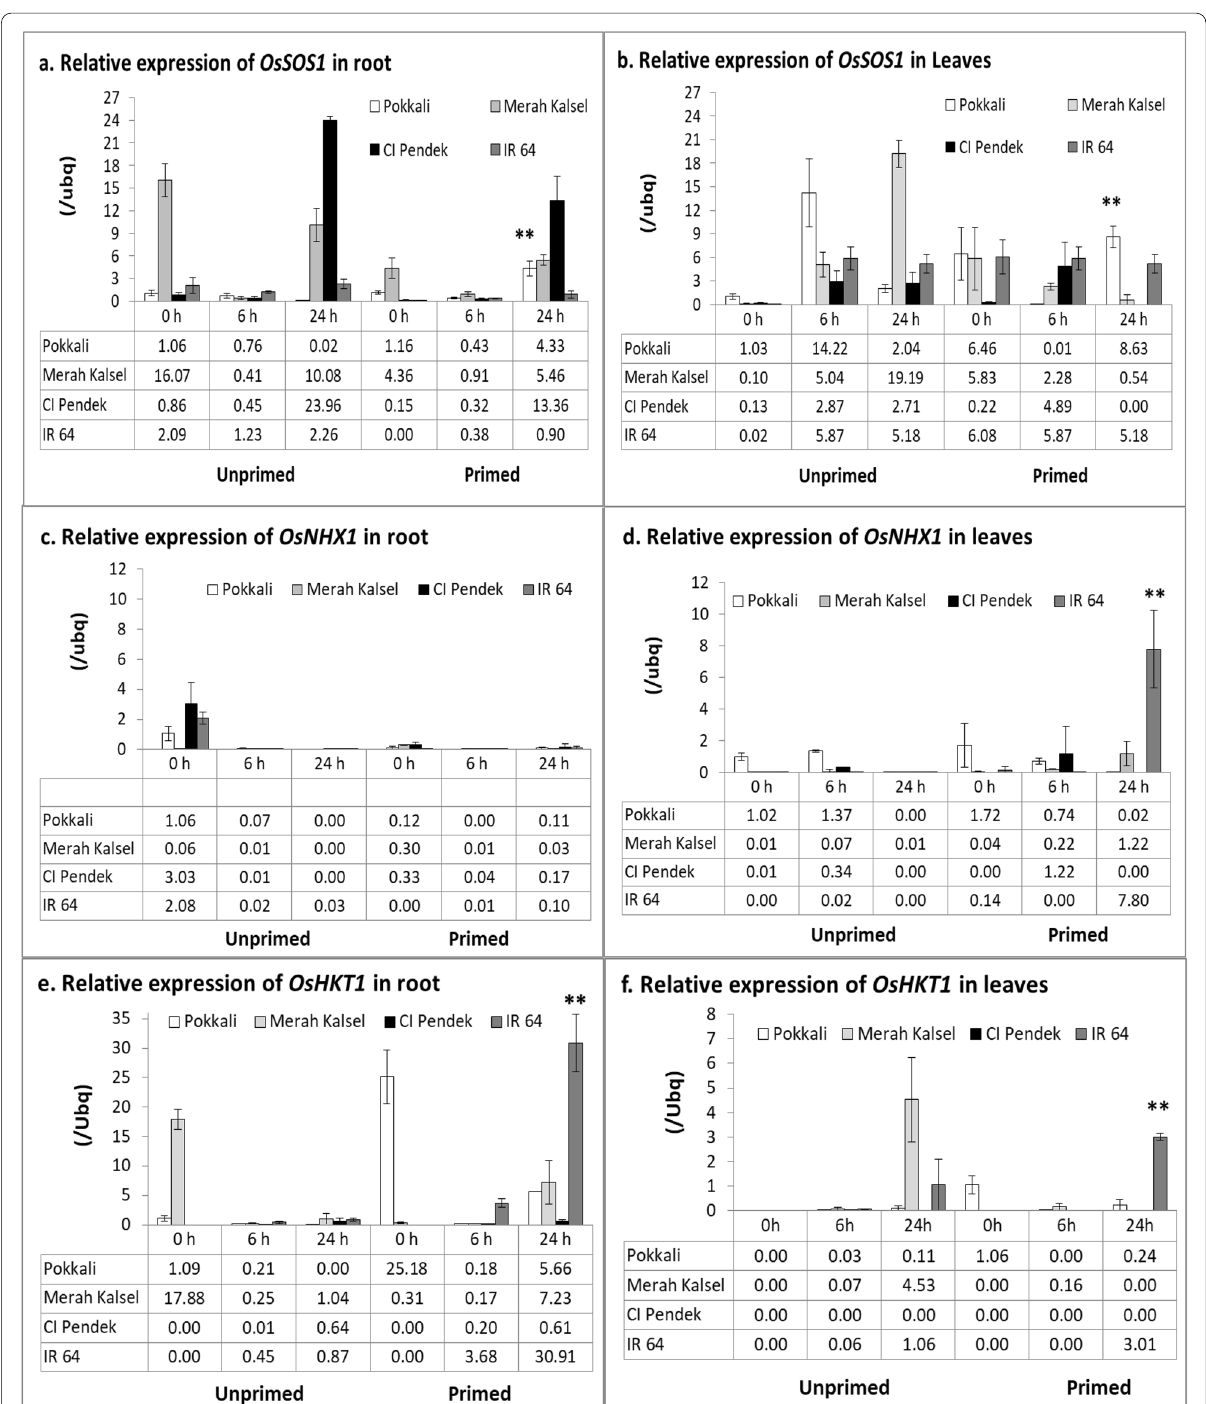
Fig. 5 Relative expression of transporter genes in roots and leaves as compared with UBIQUITIN . Expression was measured at 0, 6, and 24 h after salinity treatment (200 mM NaCl). Values are means of three replicates ±